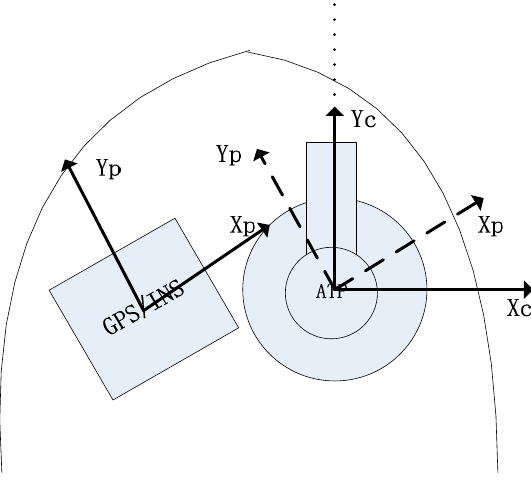
Figure 4. Error relation between the shipborne ATP and the GPS/INS unit.